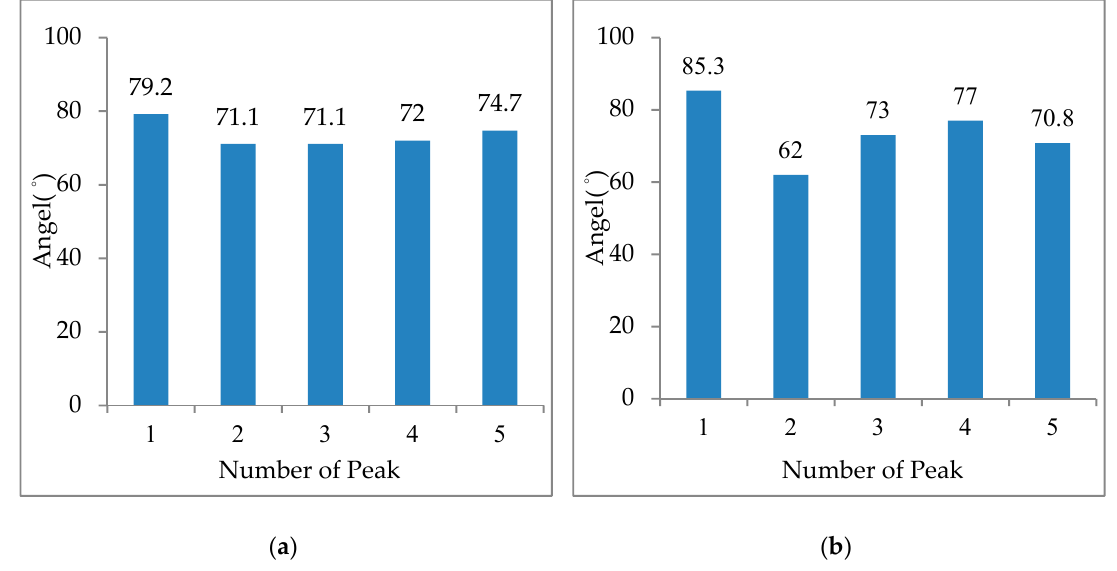
Figure 5. Flexion average angle comparison ( a ) Stability peak value and ( b ) Non stability peak